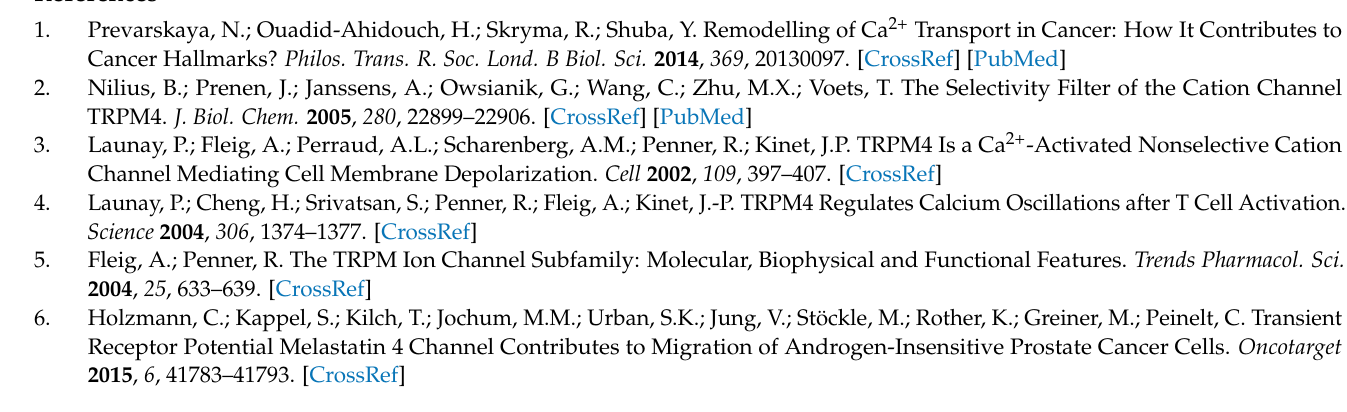
with CBA, Figure S3: Viability of HCT116 and T4KO cell lines after treatment with LBA, Figure S4: Proliferation of HCT116 and T4KO cell lines, Figure S5: Effect of LBA on HCT116 cells’ proliferation, Figure S6: Cell cycle distribution in HCT116 and T4KO cell